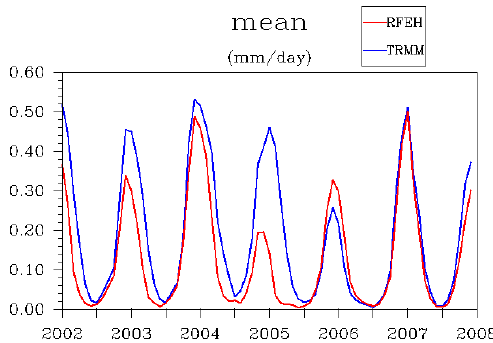
Fig. 10. Relative difference of evaporation between the two config- urations NOAQ-NF and NOAQ-F. Only the cells with a monthly flooded fraction higher than 15% over 2002–2007 are considered for the calculation.